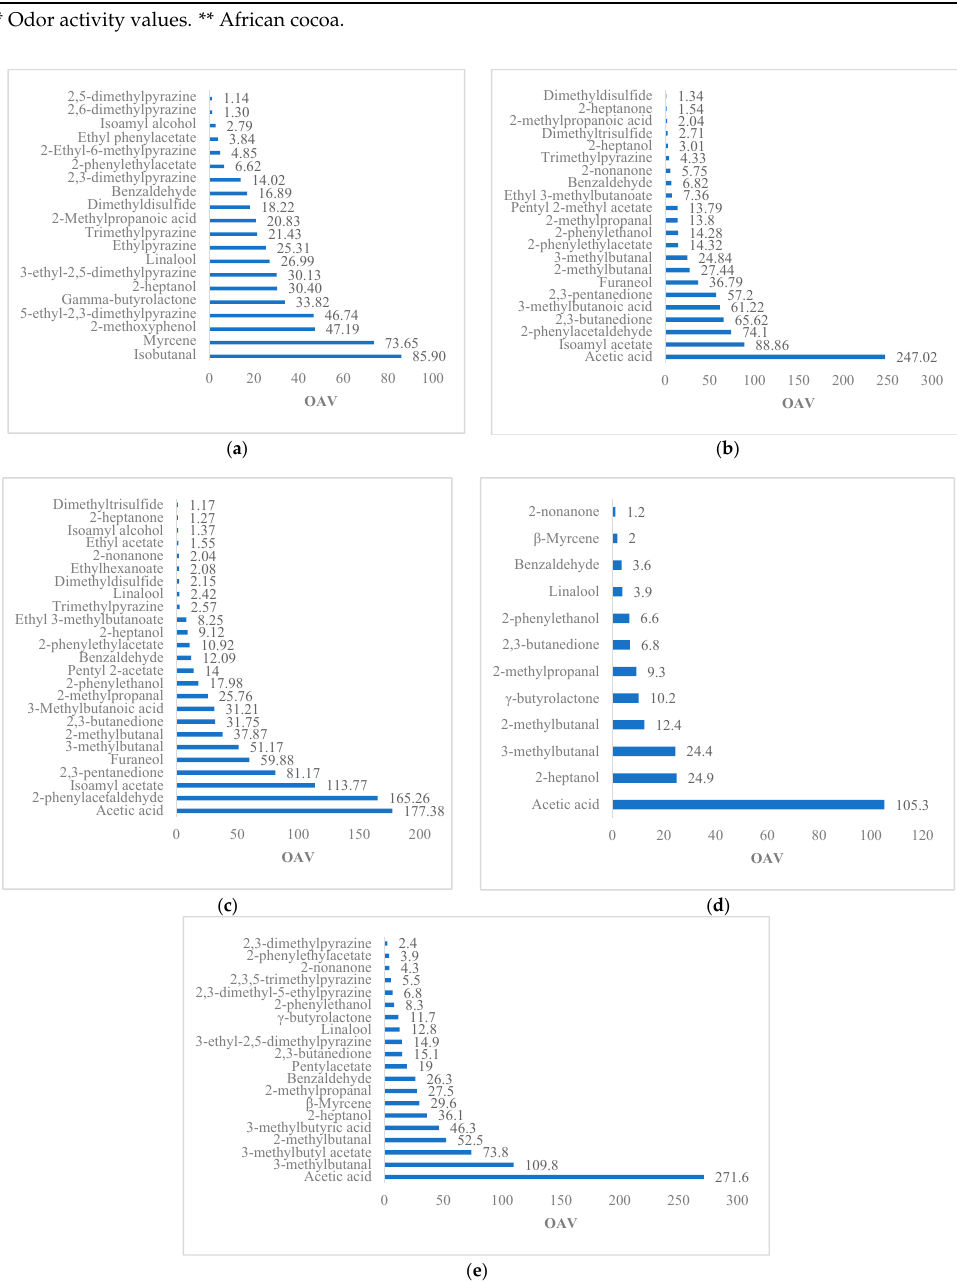
Figure 4. Studies of the volatile compounds with OAV > 1 in the liquor of the cocoa determined by ( a ) [9] in forastero cocoa beans, ( b ) [4] in CCN51 cocoa beans, ( c ) [4] in nacional cocoa beans, ( d ) [12] Ecuadorian liquor and ( e ) [12] African liquor. The compounds with an OAV < 1 include isoamyl alcohol, ethyl acetate, ethylhexa- noate, limonene, acetophenone, linalool, 2,5-dimethylpyrazine, 2,6-dimethylpyrazine, 2- ethyl-5-methylpyrazine, tetramethylpyrazine, propionic acid, 2-butanone, ethanol, 2-bu- tanol, 2-methyl-1-propanol, 2-pentylfuran, 3-hydroxy-2-butanone and ethanol, with fruity, floral, chocolate, buttery, and mainly undesirable aromas. The compounds exclu- sive to the study include rose oxide and β -myrcene that reveal floral notes in cocoa of the forastero and national variety, respectively. Smoky, acidic, hammy, or musty aromas are the common compounds in cocoa liq- uors, and are present throughout the postharvest process [79]. From 8 to 24% of the total active odor aromas (OAV > 1) correspond to undesirable compounds in cocoa liquors and dried beans, such as acetic acid, 2,3-pentanedione, 2- and 3-methylbutanoic acid, and 2- methoxyphenol. In addition, 2,3-butanedione, dimethyl di- and trisulfide, methylpropa- noic acid, and butanoic acid are in roasted beans and persist in cocoa liquor. During choc- olate processing with these liquors, the OAV partially decreases or is undetected. For in- stance, in acetic acid and 2-nonanone, the OAV decreases by 5 to 14 times, and the con- centration of 2,3-butanedione is undetected, so their OAV cannot be calculated [12]. The